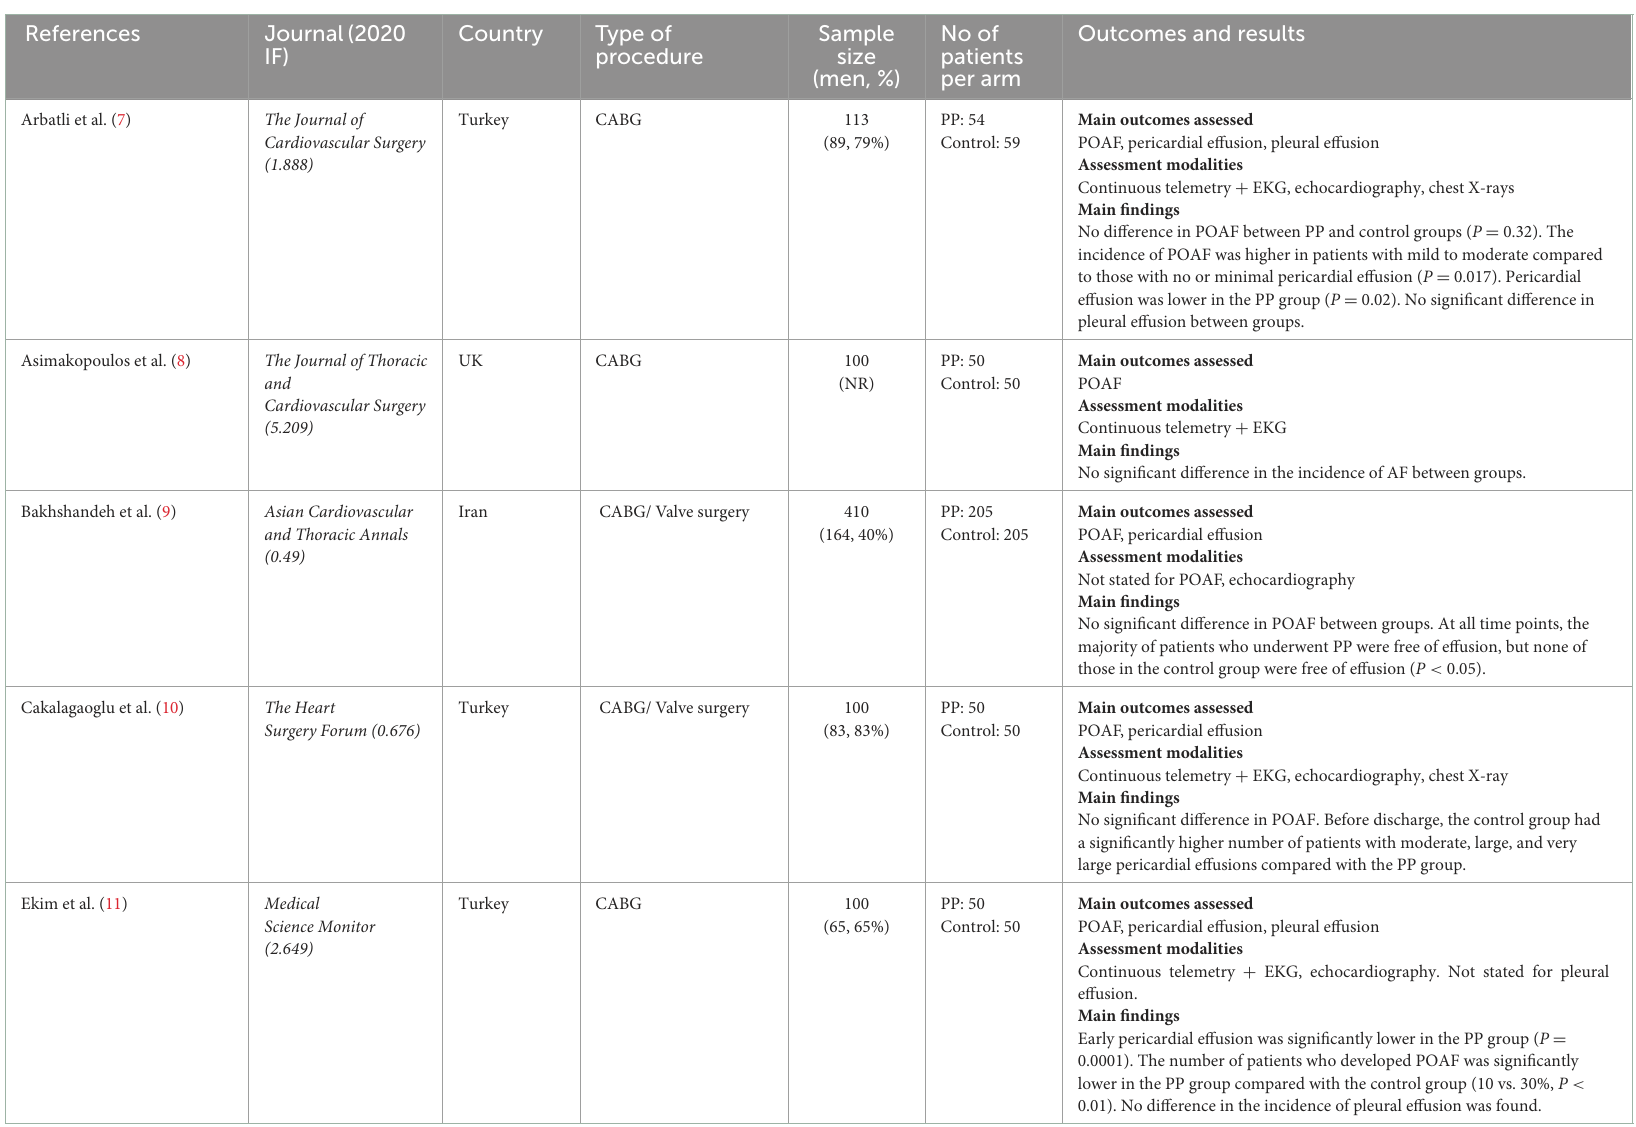
TABLE 1 Summary of the included